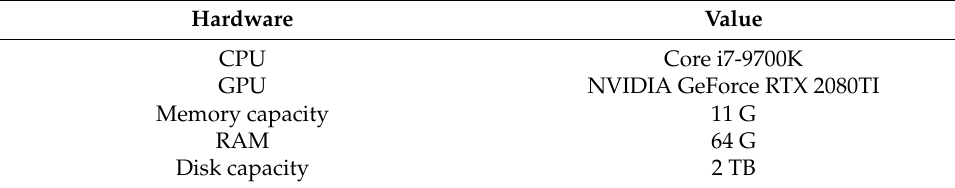
Table 1. Basic information on hardware. Hardware